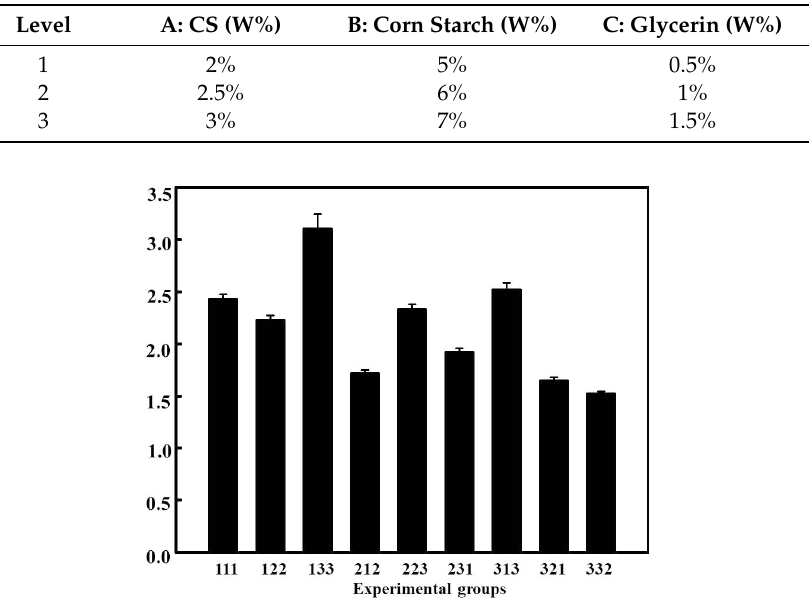
ff erent experimental groups ( p <